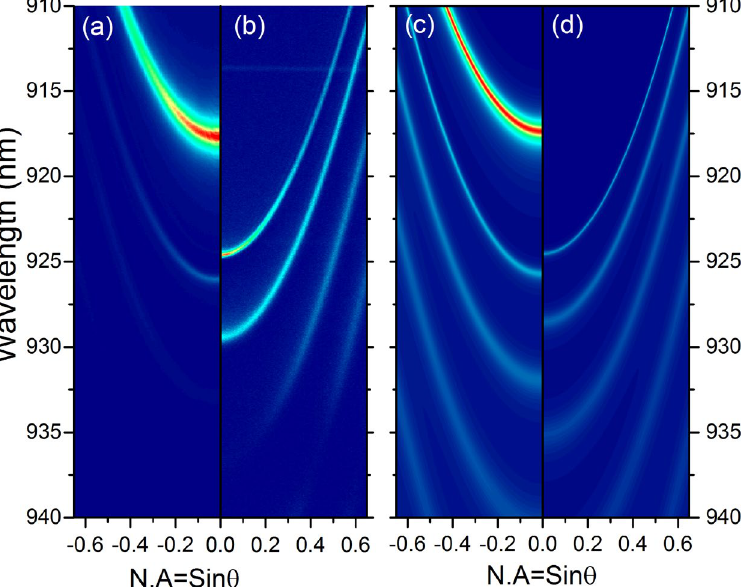
Figure 3. Experimental emission dispersion relations recorded on the ( a ) Tamm plasmon and ( b ) super Tamm plasmon (e = 35 nm) areas. ( c ) and ( d ) corresponds to reflectivities transfer matrix calculations on a Tamm and super Tamm structure,